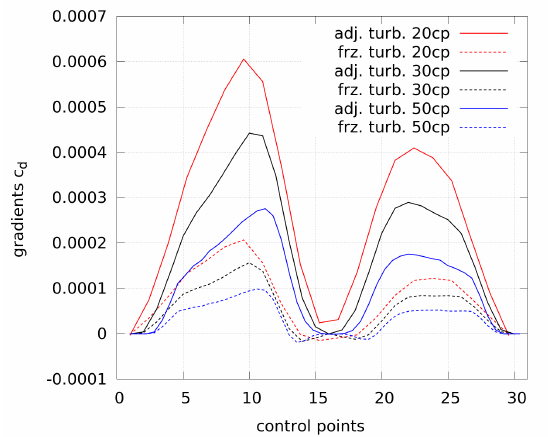
Figure 8. Gradients of the first optimization step for a decrease in drag by 3% at AoA = 2 ◦ . Frozen as well as adjoint turbulence are used. The number of control points is labeled as “XXcp”. The control points start from the trailing edge on the suction side, pass the leading edge, and end at the trailing edge on the pressure side.